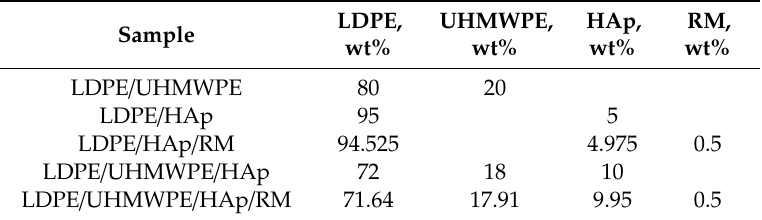
Table 1. Composition of samples. LDPE, low density polyethylene; UHMWPE, ultra-high molecular weight polyethylene; HAp, hydroxyapatite; RM,